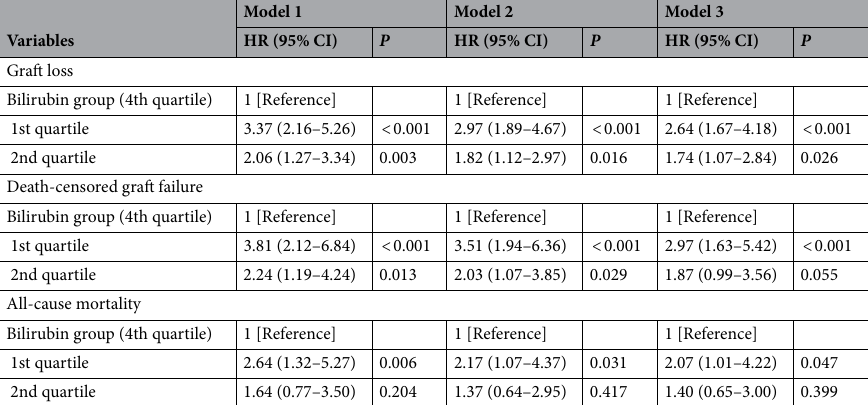
Table 4. Association between serum bilirubin levels and graft loss, death-censored graft failure, and mortality. Model 1 adjusted for age, sex, and BMI. Model 2 adjusted for age, sex, BMI, donor status (deceased versus eGFR.